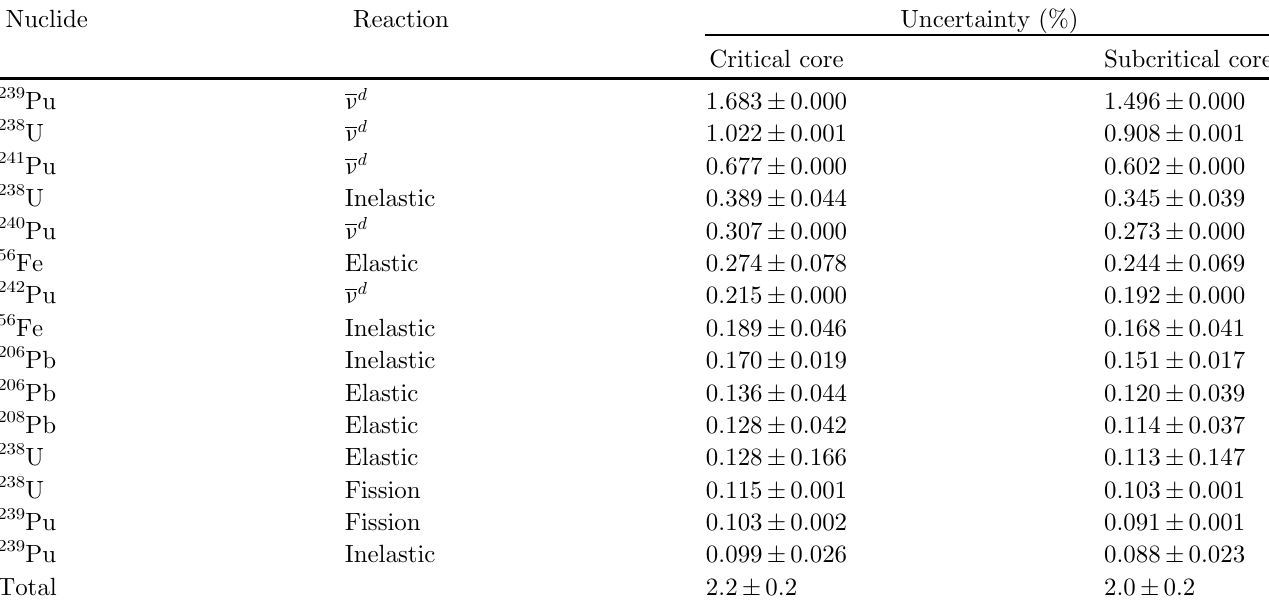
uncertainty with 1 s statistical uncertainties ( a = 20, top eff